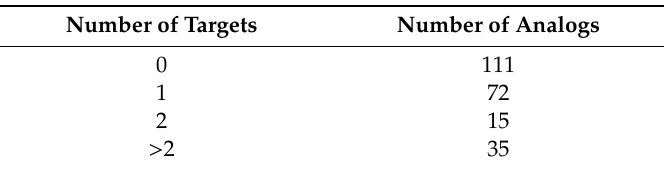
Table 2. Target count for MTL analogs. For MTLs, a systematic search for structural analogs was carried out in PubChem. The search identified 233 MTL analogs, for which the number of targets they were active against is